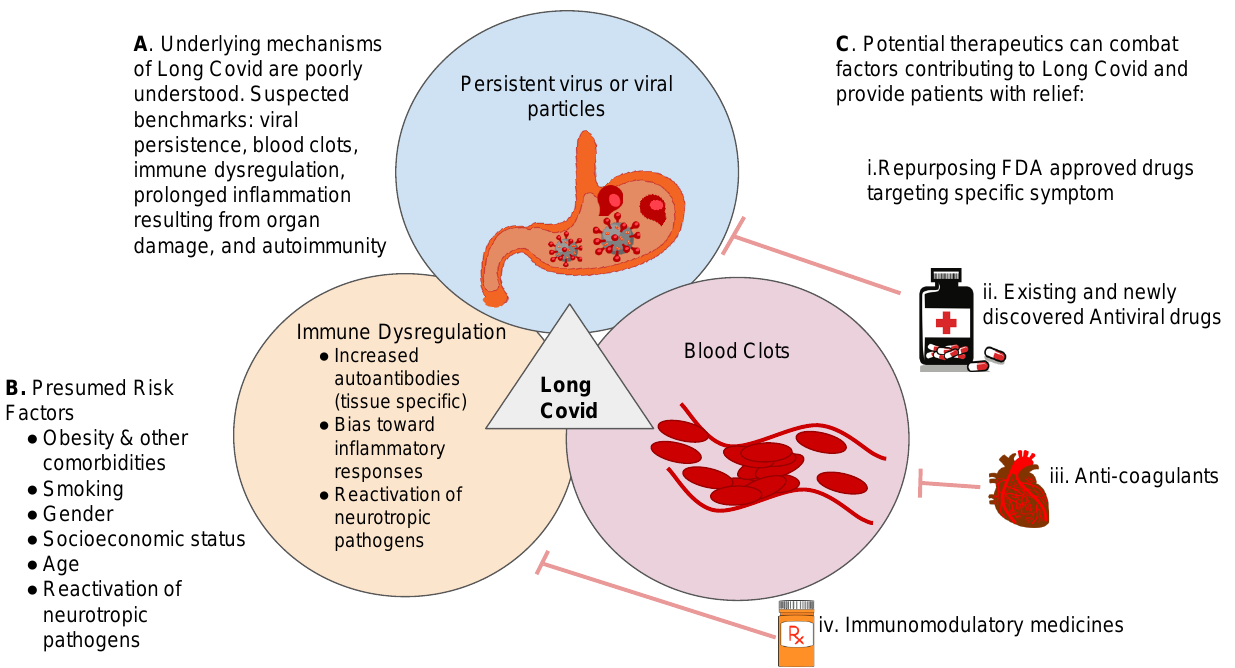
Figure 2. Factors Contributing to Long Covid and Potential Treatment Options. Panel A depicts suspected determinants contributing to Long Covid such as the presence of a virus or viral frag- ments after recovery from acute infection, chronic inflammation from organ damage, blood clotting dysfunction, and dysregulation of immune responses; Panel B demonstrates various risk factors including comorbidities, smoking, gender, age, and reactivation of latent pathogens; Panel C depicts potential therapeutic approaches, which include repurposing FDA approved drugs targeting specific symptom, the use of existing or newly discovered anti-viral drugs, anti-coagulant treatments and the use of immunomodulatory